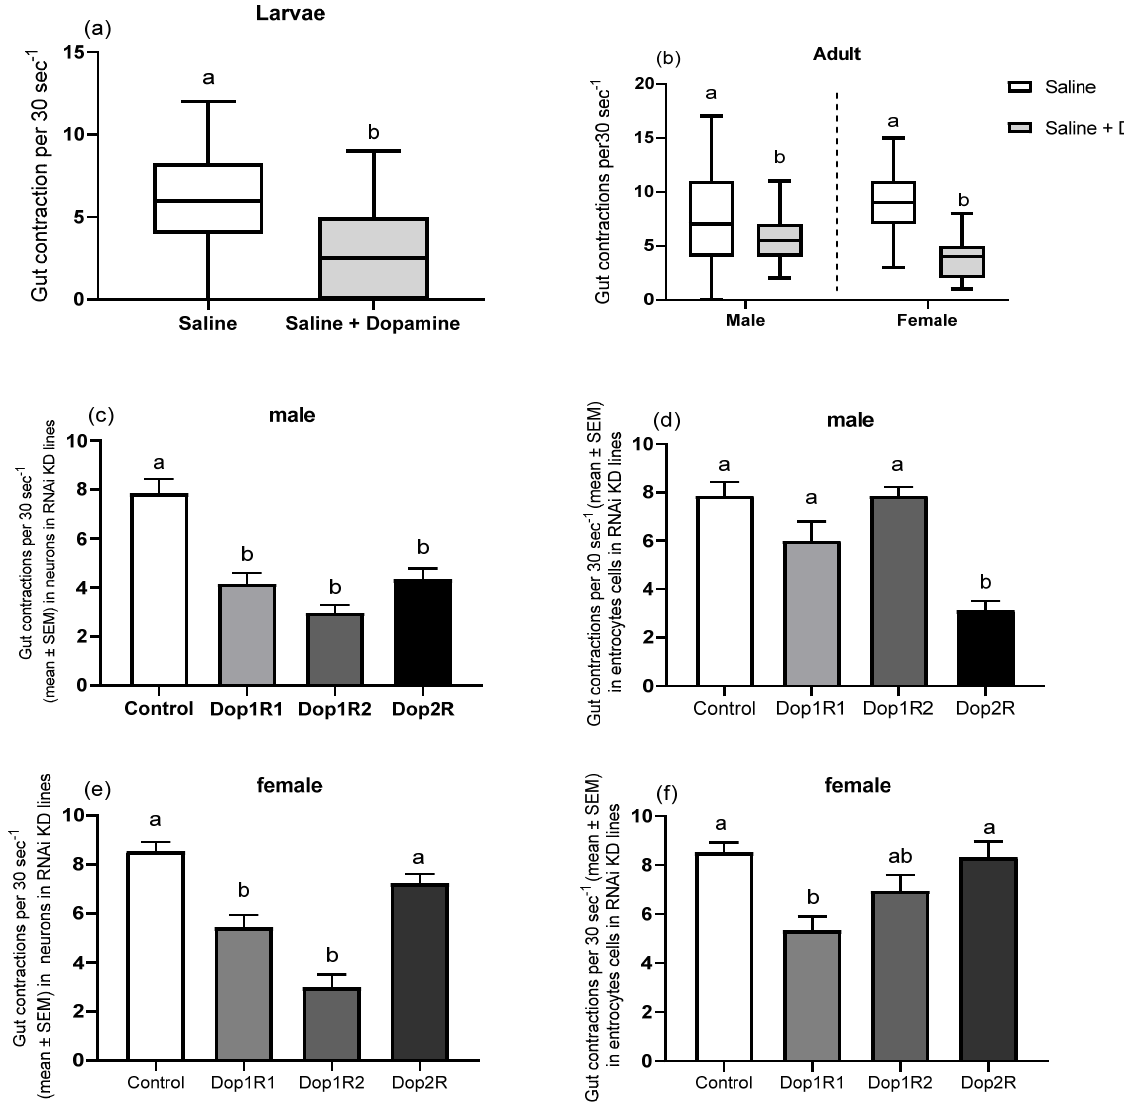
Figure 1. The gut content ( a , b ) and the fecal pellets count ( c , d ) of adult flies ( n = 5) fed on blue food media spiked with different concentrations of dopamine compared to control flies fed standard food media without dopamine. Symbols on the box plot represent the maximum and minimum values (whiskers: ┬ ┴ ) and mean values (-). Different lowercase letters indicate statistically significant dif- ferences between treatments (one-way ANOVA with Tukey’s post hoc test, p < 0.05).